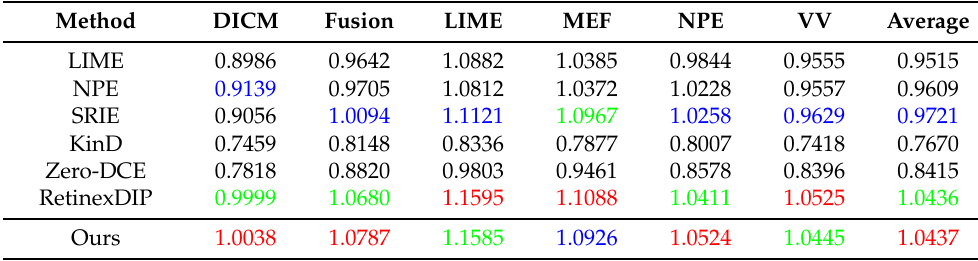
Table 3. Comparison of average CPCQI on six datasets. (The red, green, and blue scores represent the top three in the corresponding dataset,